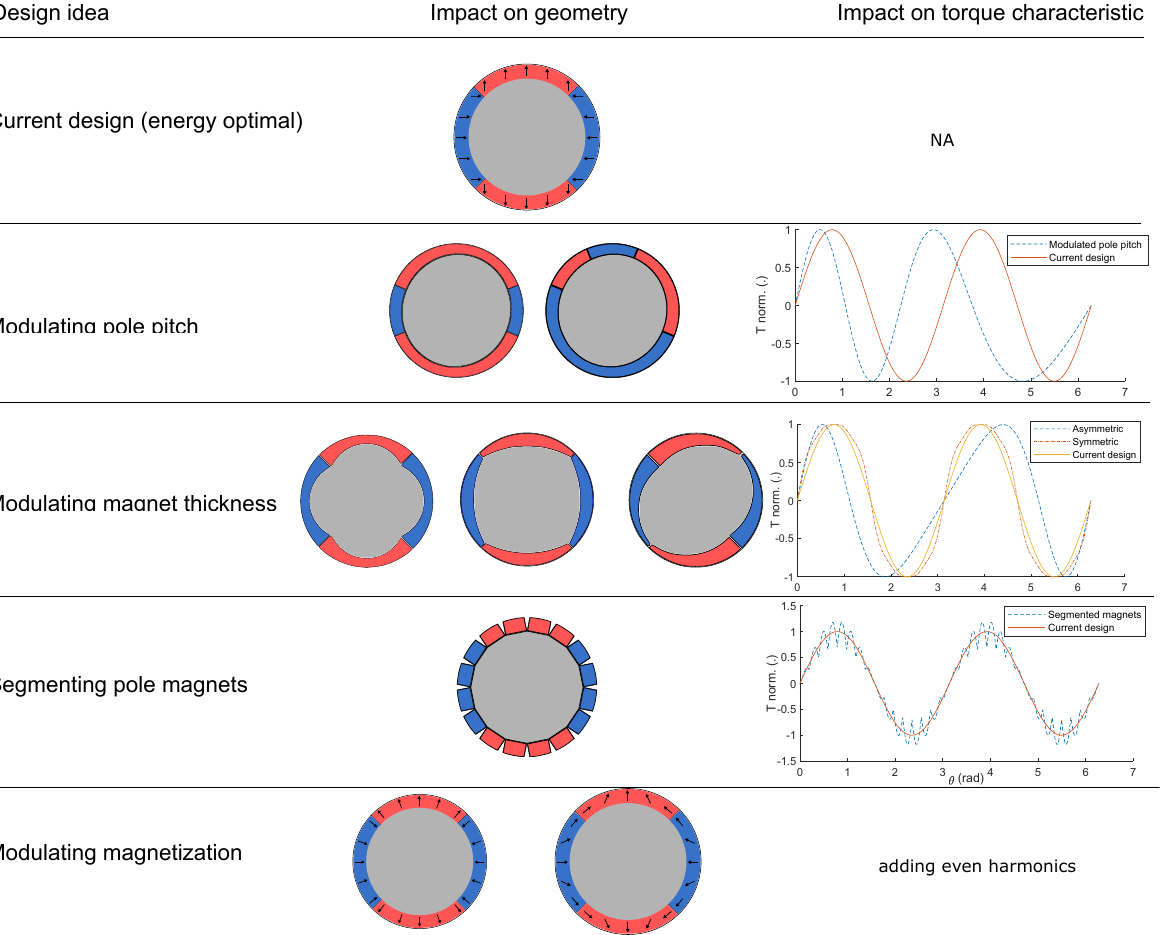
Figure 3. Magnet shape variations based on engineering insight, with corresponding torque